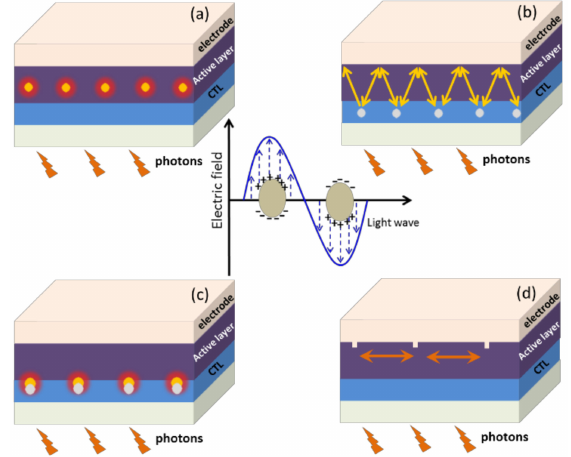
Figure 1. Architecture of OPV solar cells with plasmonic metallic NPs. ( a ) NPs in the active layer for LSPR enhancement; ( b ) NPs in the charge carrier transport layer (CTL) as light trapping centers due to the forward scattering effect; ( c ) NPs in CTL that induced the enhancement of the electromagnetic field in the photoactive layer due to the LSPR effect; ( d ) light trapping by the excitation of surface plasmon polaritons (SPP) at the metal/semiconductor interface. The center graph is a mechanism illustration of localized surface plasmon in metallic